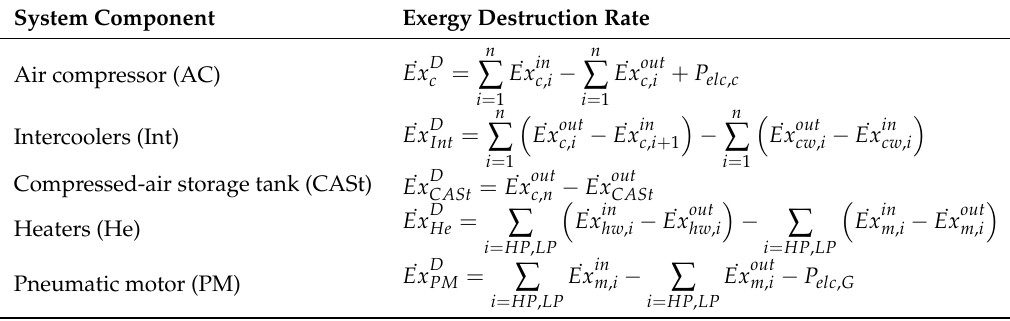
Table 1. Expression of the rate of exergy destruction for proposed storage system relevant components. System